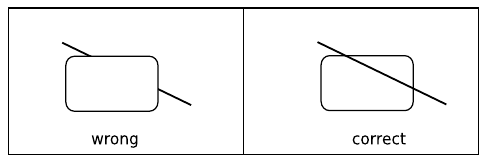
Figure 4.2: If an edge crosses a node, the edge must be drawn on top of the